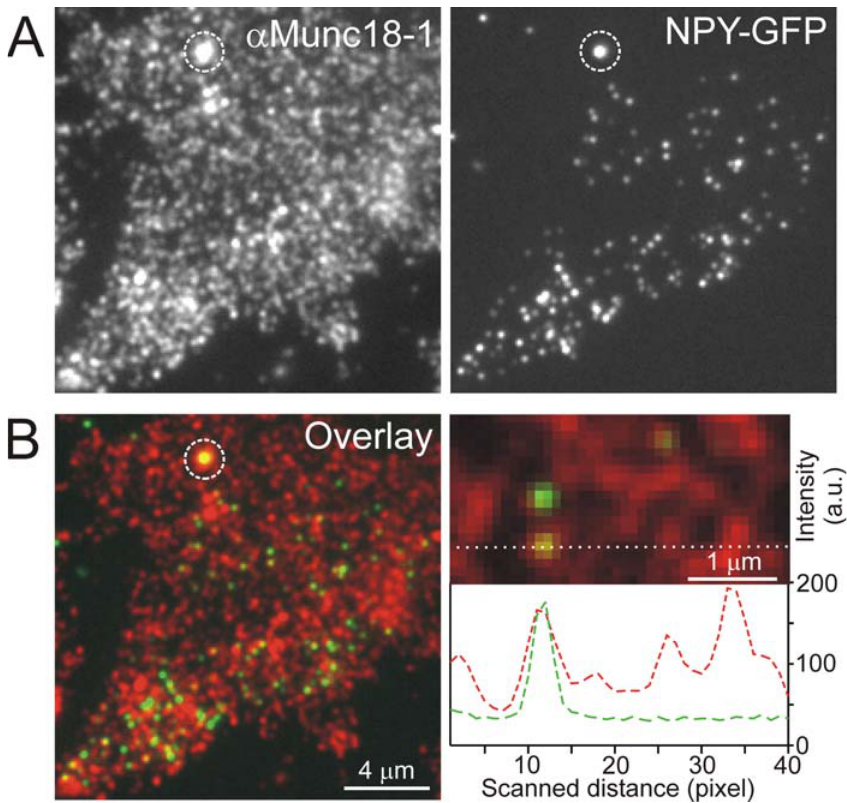
Figure 2. Docking of Secretory Granules to Plasmalemmal Domains Enriched in Munc18–1 (A) Plasma membrane sheet generated from a PC12 cell expressing the secretory granule marker NPY-GFP. Left, immunostaining for Munc18–1 (red channel); right, plasma membrane–docked, GFP-filled secretory granules (green channel). Circle indicates a fluorescent bead visible in all channels acting as a spatial reference for vertical shifts occurring during filter change. (B) Left, overlay from images shown in (A); right, magnified view from overlay. Linescans were placed through the centers of individual secretory granules (174 granules from ten membrane sheets were analyzed; for example, see dotted line), and granules were rated to be associated with a Munc18–1–rich domain when both signals had a maximum to within two pixels. Random co-localization was determined on mirrored images and subtracted (for details see Materials and Methods), resulting in 70% specific co-localization of granules with Munc18–1 domains. DOI: 10.1371/journal.pbio.0040330.g002